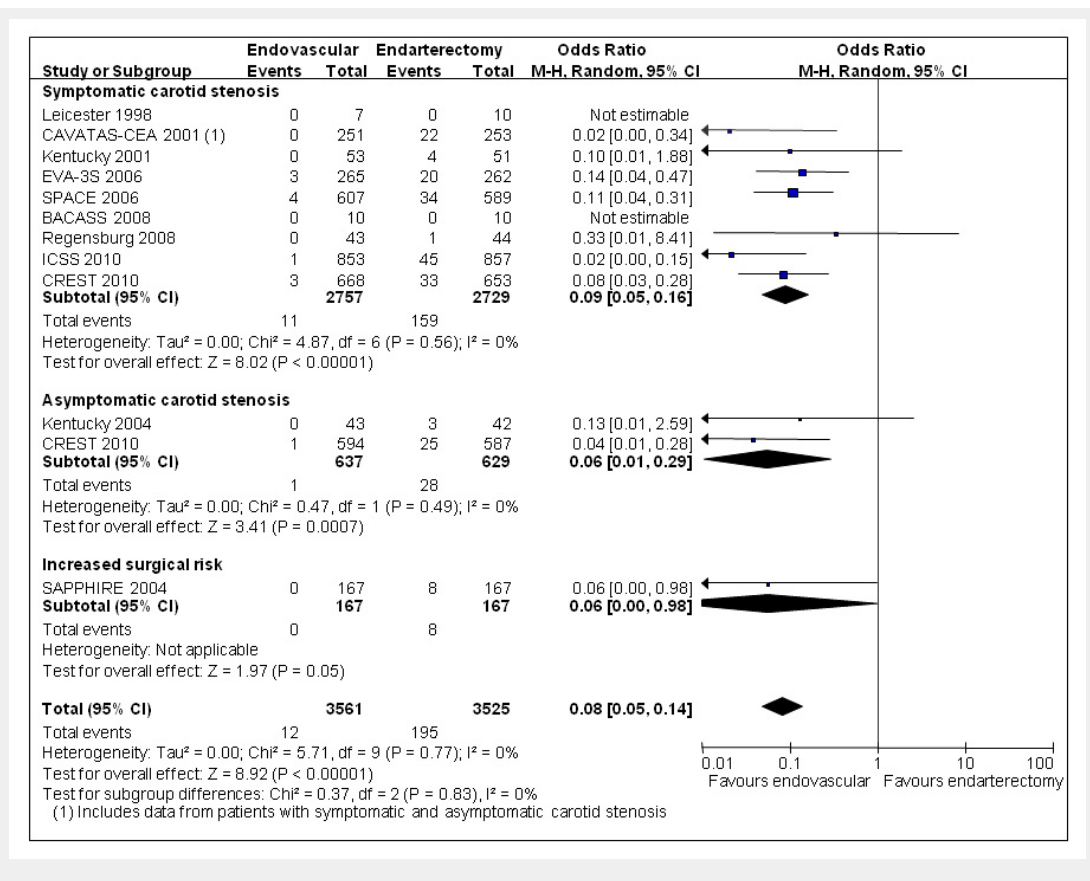
Figure 5 Meta-analysis of randomised trials comparing endovascular treatment with endarterectomy for symptomatic or asymptomatic carotid stenosis: cranial nerve palsy between randomisation and 30 days after treatment. Data are numbers of patients with events, total numbers of patients and Mantel-Haenszel random-effects odds ratios including 95% confidence intervals (CI) for cranial nerve palsy occurring between randomisation and 30 days after treatment, with endarterectomy as the reference treatment. Squares on the right represent point estimates of odds ratios at trial level, with 95% CI as horizontal bars. The diamond at the bottom represents the summary OR and 95% CI. Data from the following trials are included: Leicester [46], CAVATAS [13], Kentucky [48, 53], SAPPHIRE [43], EVA-3S [14], SPACE [15], BACASS [50], Regensburg [52], ICSS [17], CREST